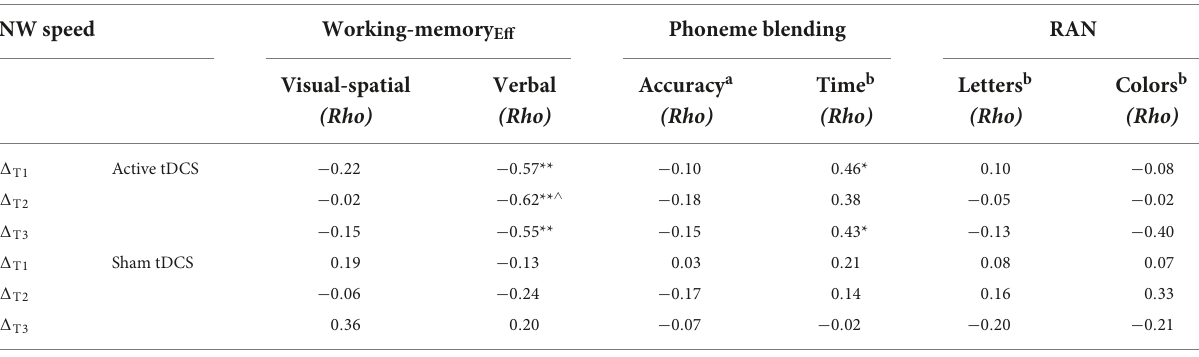
TABLE 3 Correlations between neuropsychological measures at T0 and (cid:49) T1 , (cid:49) T2 , (cid:49) T3 NW reading speed, controlling for age, in the active and sham tDCS conditions. Neuropsychological measures at T0 NW